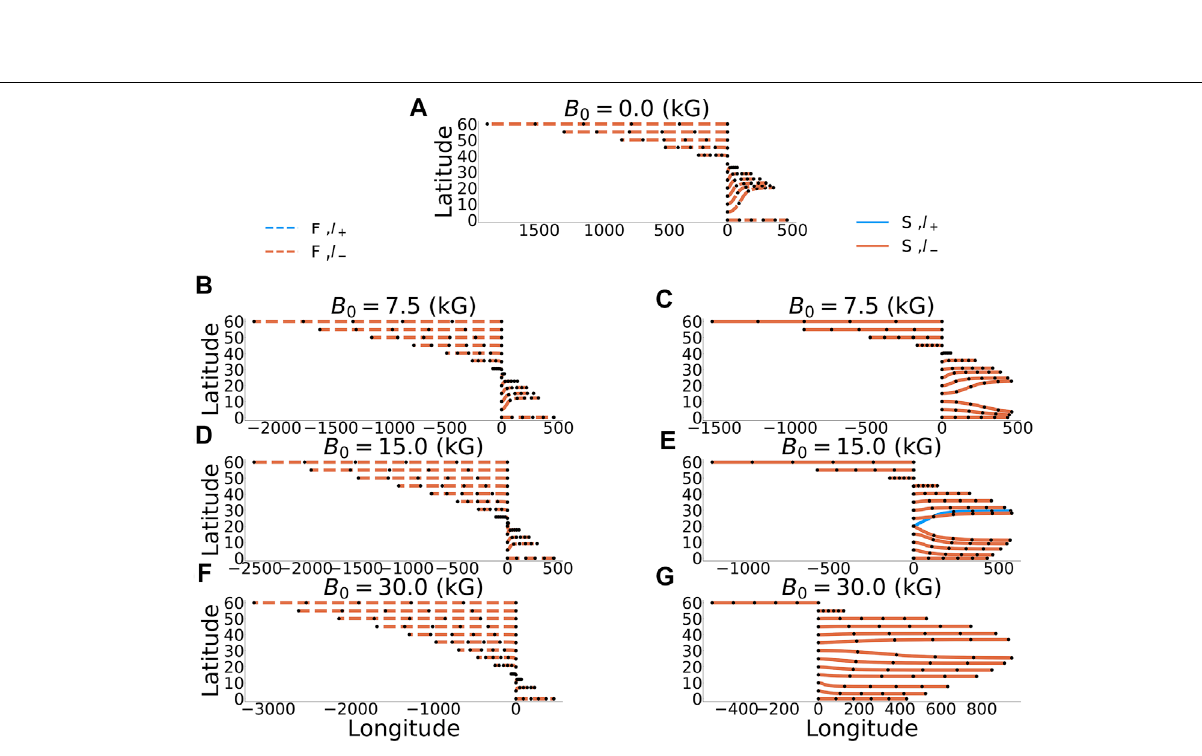
Frontiers in Astronomy and Space Sciences |